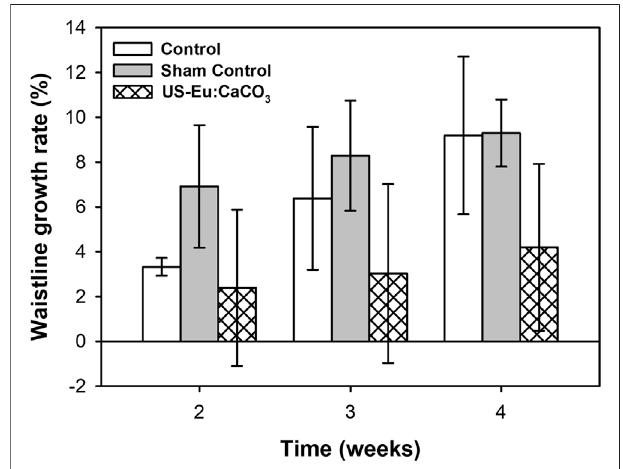
FIGURE 10 | The weight growth rate of SD rats treated with CaCO 3 : Eu and exposed to ultrasonic irradiation.